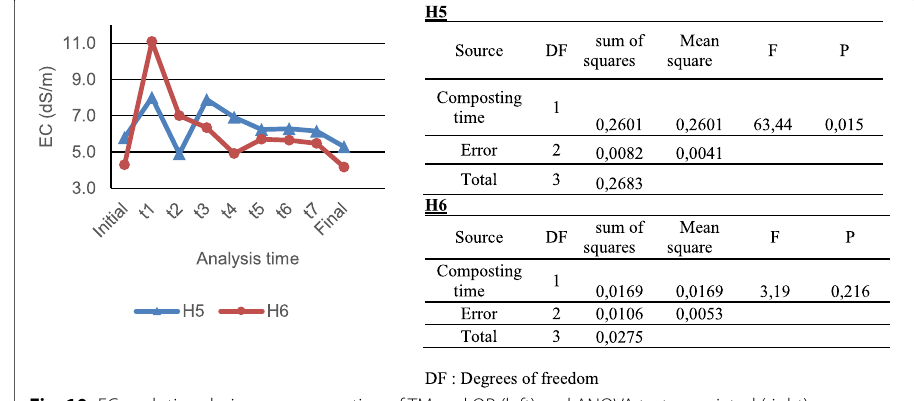
Table 13 ANOVA test associated with C/Ni and TF effects on EC Source DF ASS SSS F